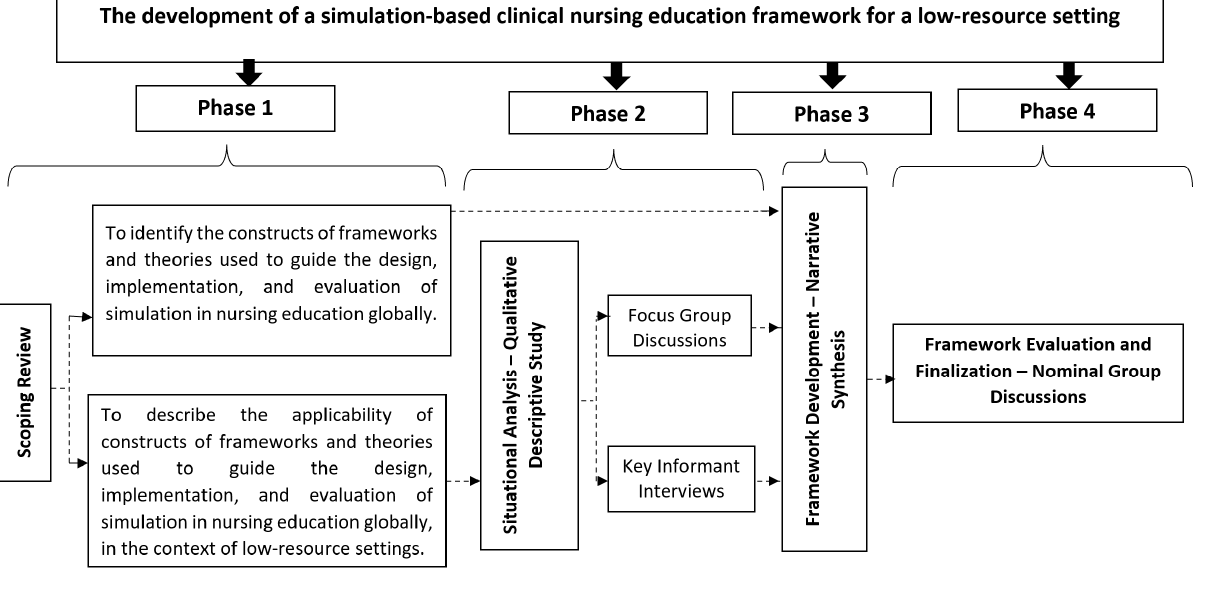
Figure 1. A flow chart of the sequential multimethod research design conducted in four phases.